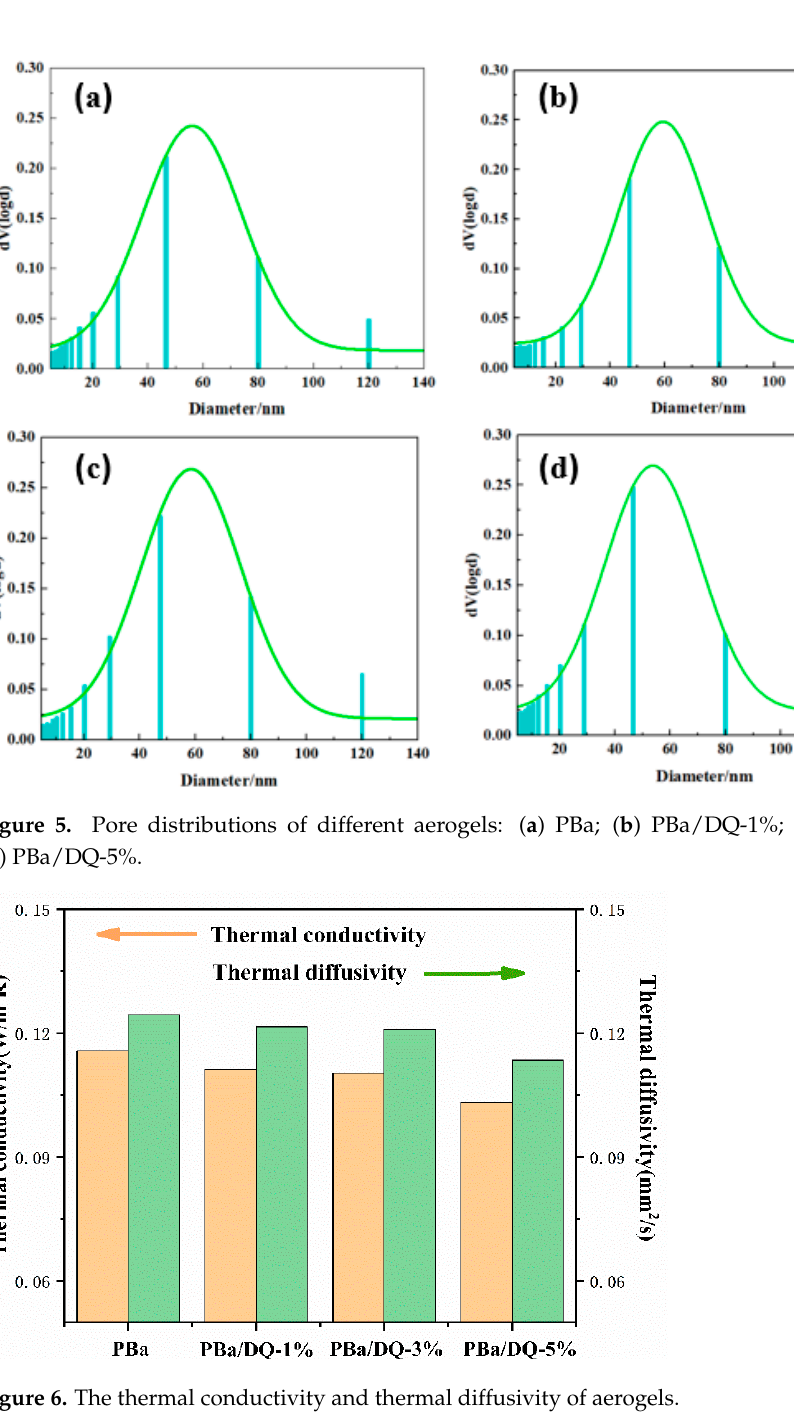
Figure 6. The thermal conductivity and thermal diffusivity of aerogels.